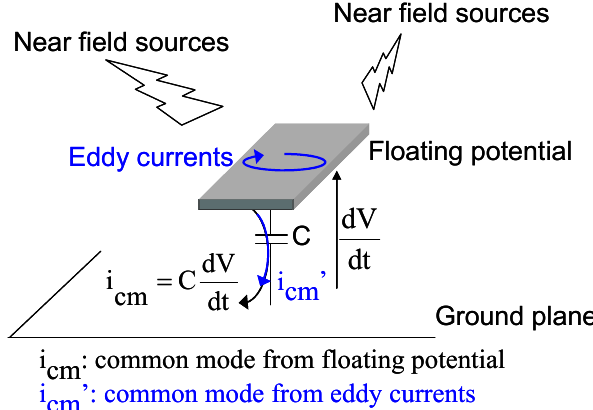
Figure 1. Voltage driven mechanism of common mode current generation.